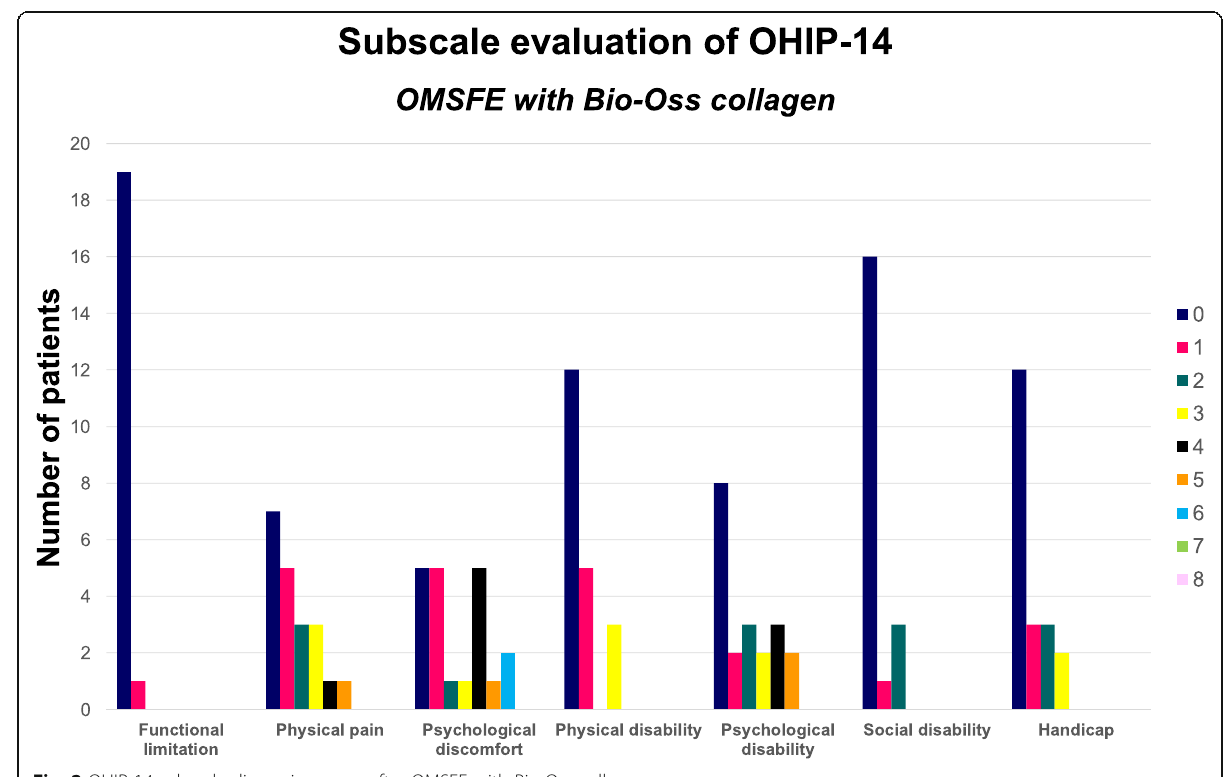
Fig. 2 OHIP-14 subscale dimension score after OMSFE with Bio-Oss